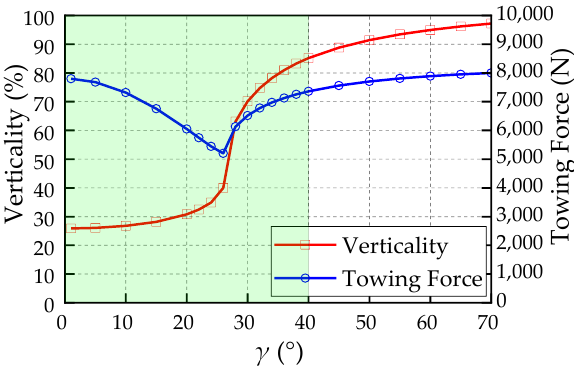
Figure 17. Verticality and towing force vs. bank angle.